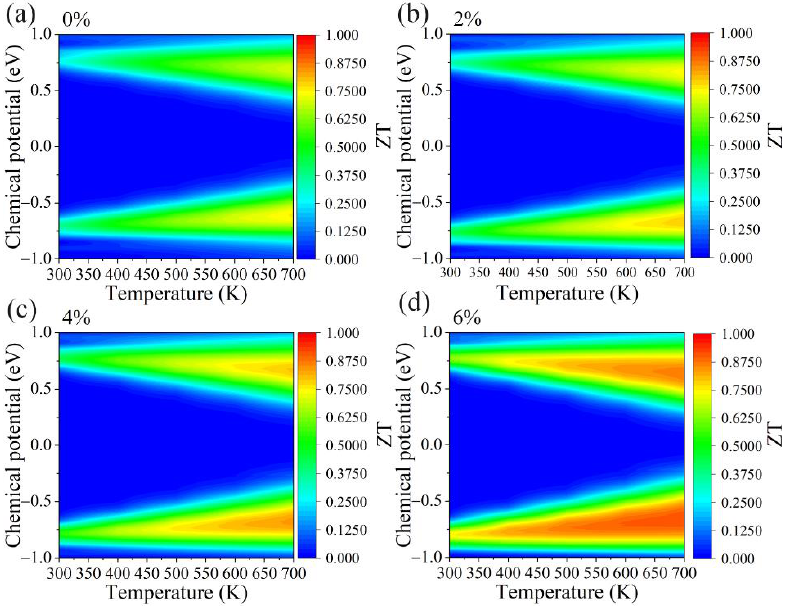
Figure 11. The contour map of the figure of merit ZT with respect to chemical potential under different biaxial tensile strains of ( a ) 0%, ( b ) 2%, ( c ) 4% and ( d ) 6% for GeS 2 monolayer.